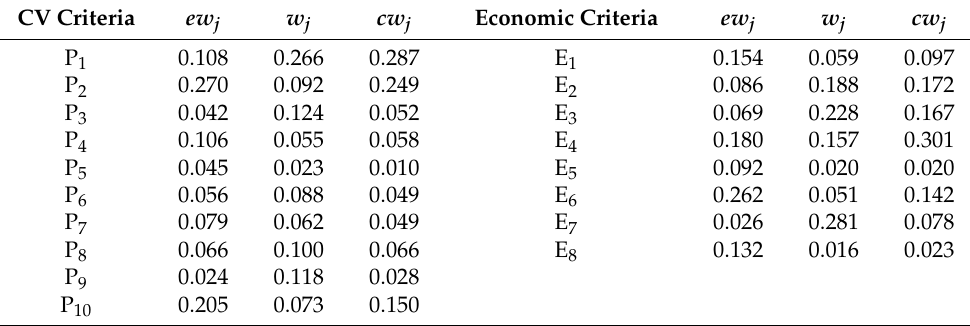
Table 9. Comprehensive weight of evaluation criteria with respect to CV and economic. CV Criteria ew